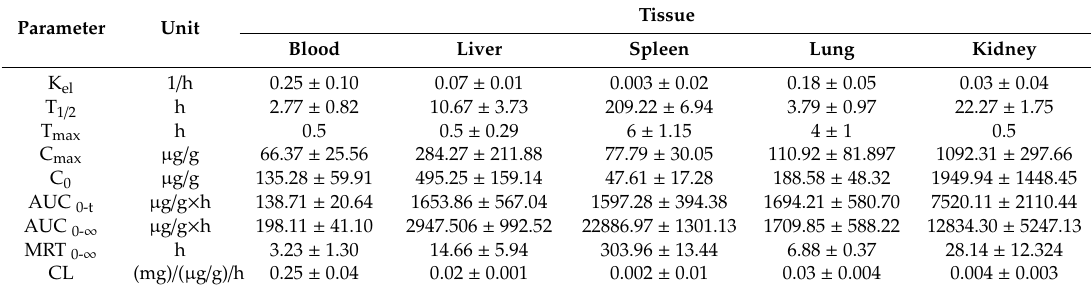
Main pharmacokinetic parameters of FITC-fucoidan in mice tissues by intravenous administration (50 mg /